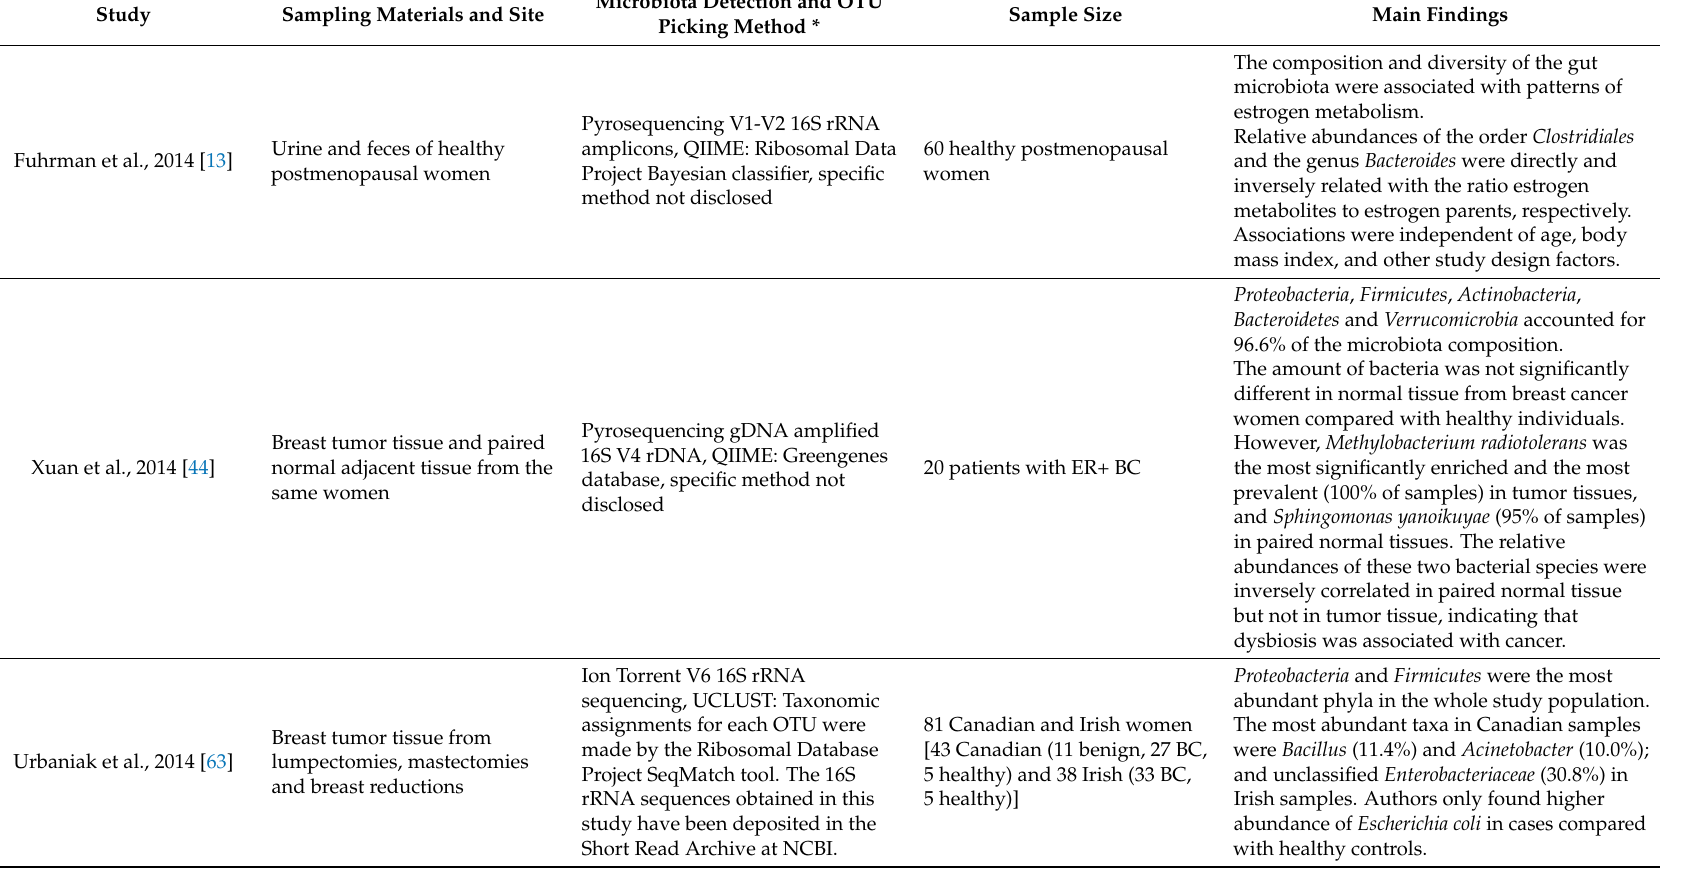
Table 1. Human studies dealing with microbiota and breast